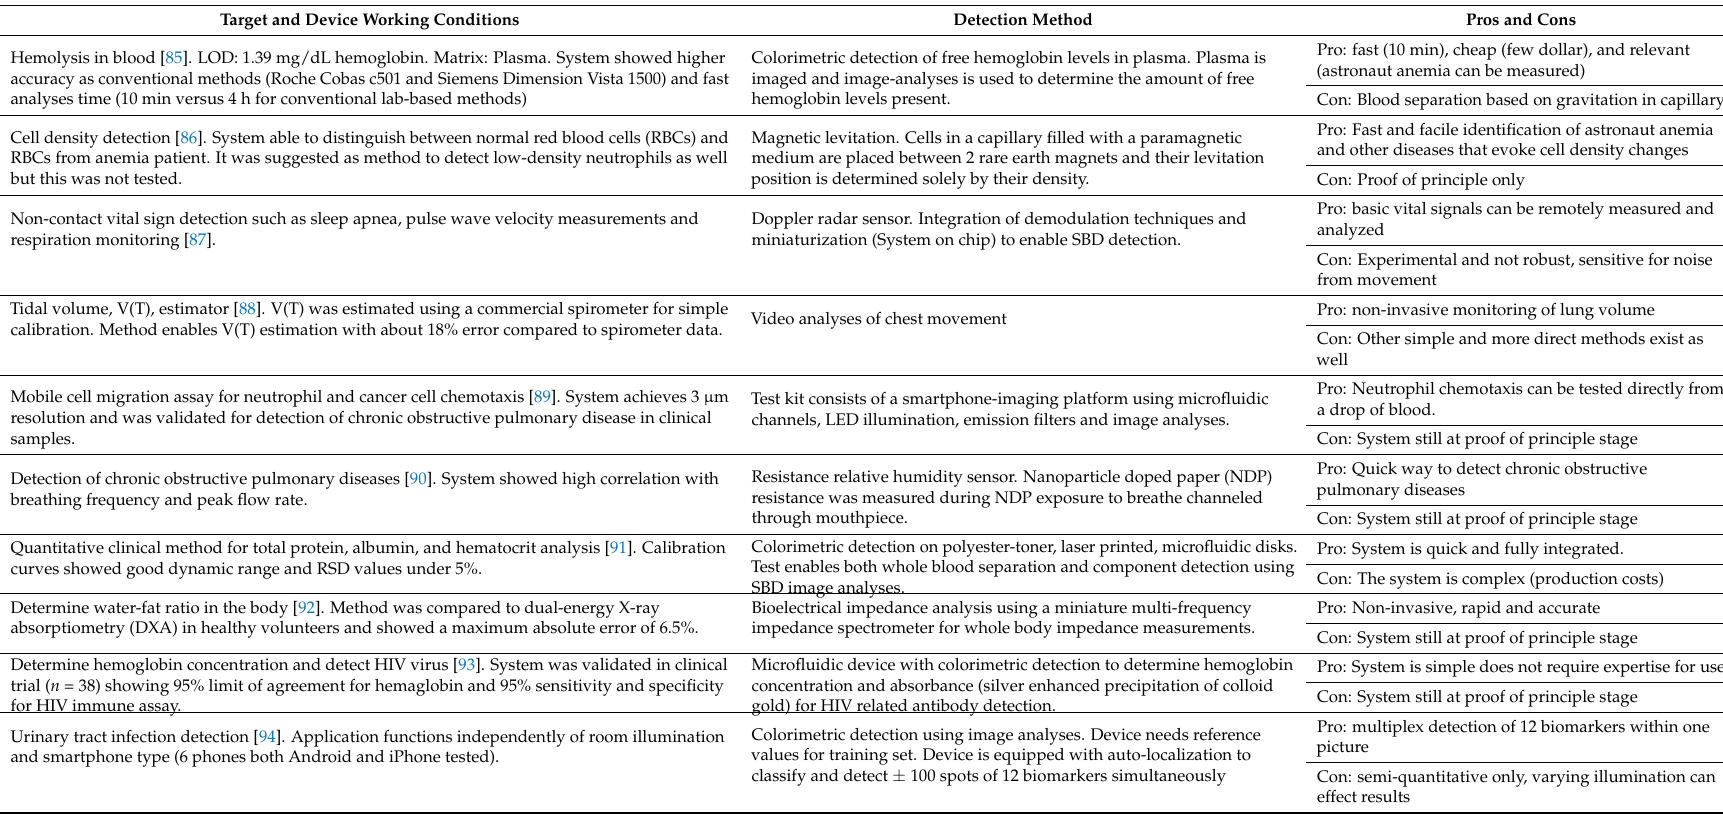
Table 1. A list of SBDs developed to monitor general health features relevant for space